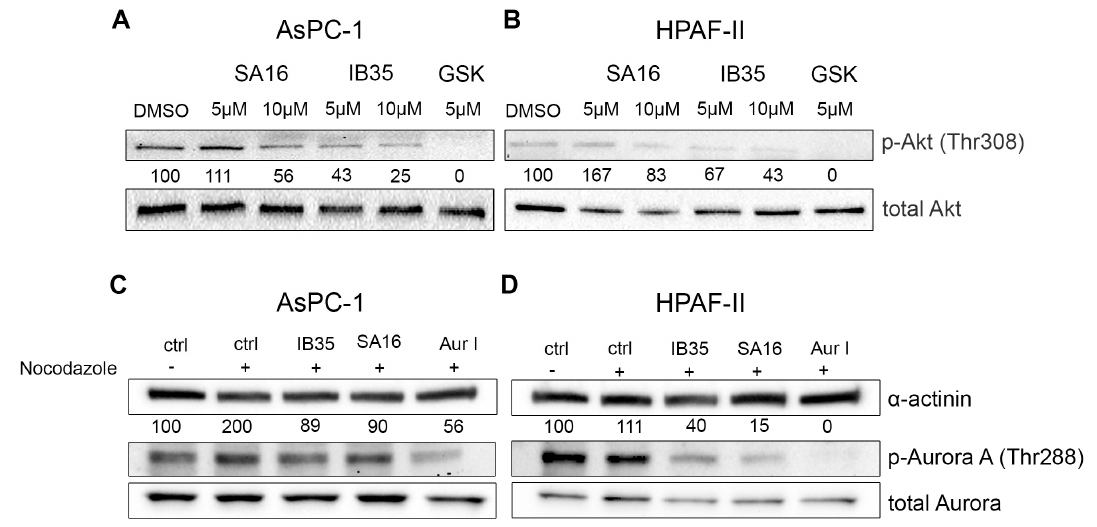
Figure 4. E ff ect of SA16 and IB35 on signaling pathways in pancreatic cancer cell lines. AsPC-1 ( A ) and HPAF-II ( B ) were serum starved for 24 h and then stimulated with FBS (DMEM + 10% FBS) for 1 h in the presence or absence of SA16, IB35, and GSK2334470 (5 µ M) prior to cell lysis. AsPC-1 ( C ) and HPAF-II ( D ) were treated with nocodazole for 24 h and then treated with SA16, IB35, or Aurora-A Inhibitor I (10 µ M) for 1 h prior to cell lysis. Lysates were then assessed by Western blotting using the indicated antibodies. Representative blots of at least three independent experiments are shown. In all blots, Akt total ( A , B ) and α -actinin ( C , D ) were used as loading control. In ( A , B ) membranes incubated with pAkt (Thr308) were stripped and re-incubated with anti Akt. The percentage of phosphorylated Akt is calculated by normalization to the loading control total Akt. In ( C , D ) membranes incubated with pAurora (Thr288) were stripped and re-incubated with anti-Aurora A. The percentage of phosphorylated Aurora A is calculated by normalization to the loading control α -actinin.